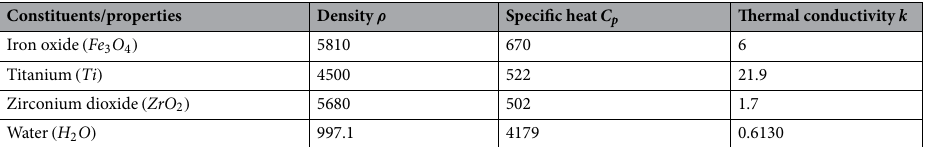
Table 2. Experimental description of thermophysical characteristics of nanoparticles and base fluid (Mukhtar et al. 44 ) and (Eid et al. 45